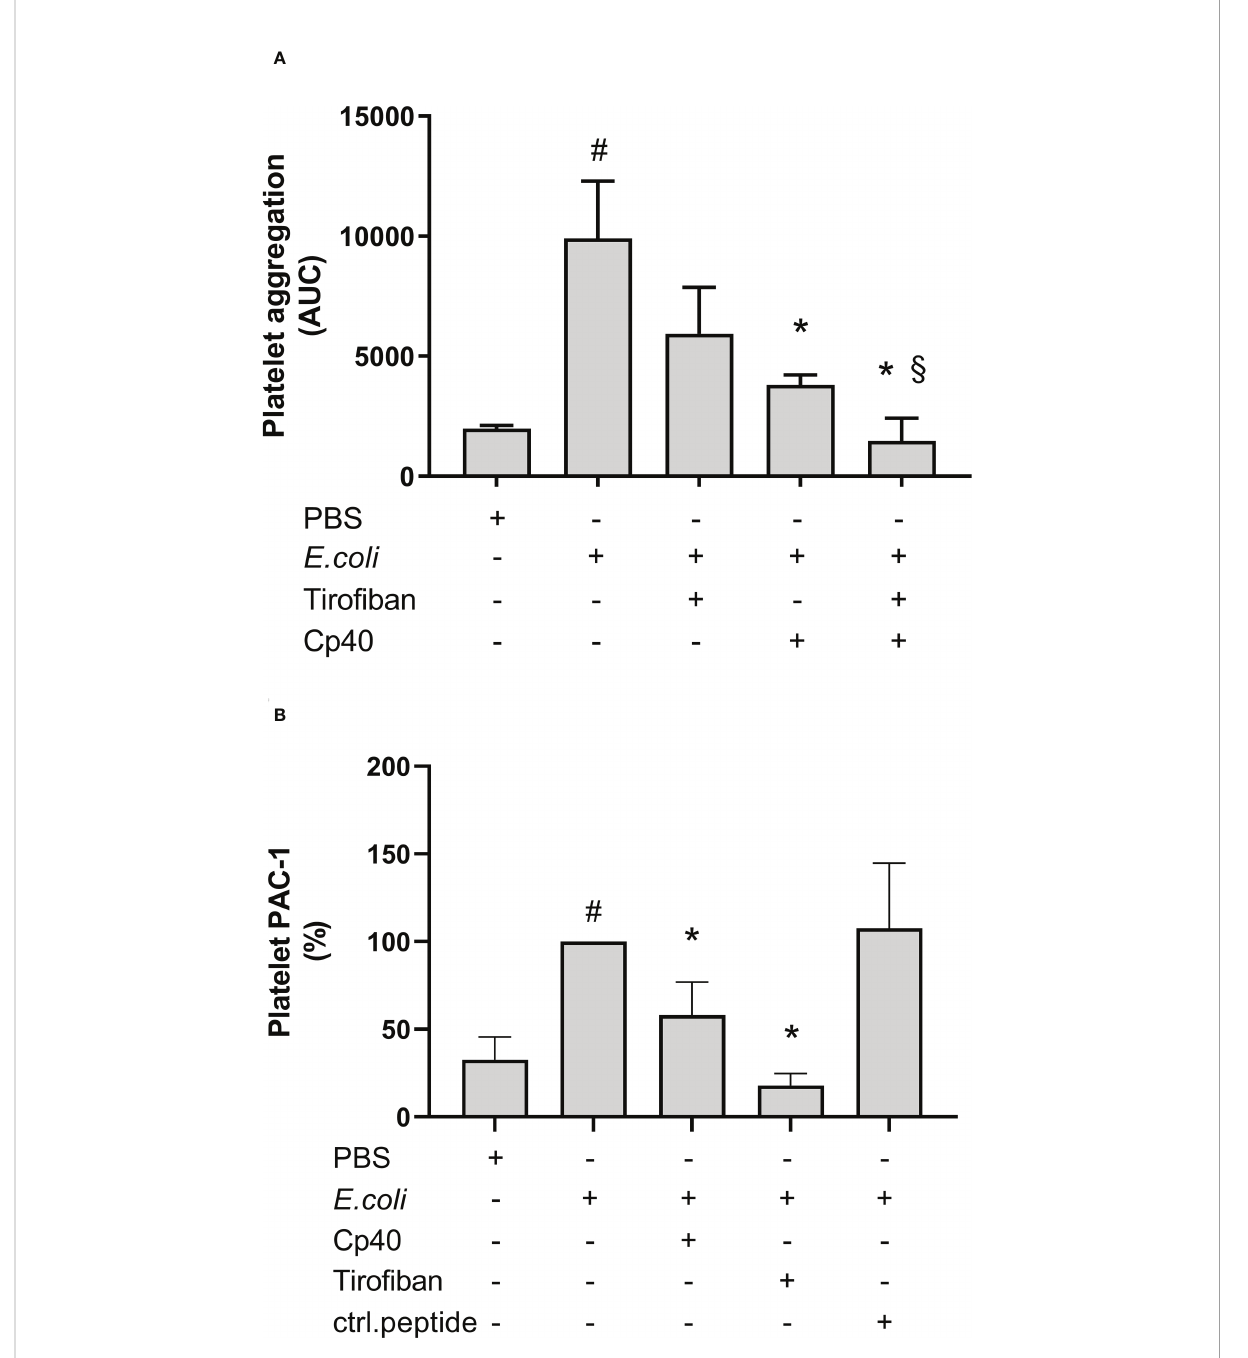
FIGURE 7 The role of glycoprotein (GP) IIb/IIIa on Escherichia coli ( E. coli 5.3 x 10 9 /mL)-induced platelet aggregation measured by Multiplate ® impedance aggregometry (A) . To the samples were added phosphate-buffered saline (PBS) control, tiro fi ban (5 µg/mL), compstatin (Cp40, 20 µM) or the combination of tiro fi ban and compstatin, and PBS or E. coli as activators. The results are given as the area under the curve (AUC), using median ± interquartile range (n = 6). The effect of C3-inhibition on the E. coli -induced (1 x 10 9 /mL) activated GPIIb/IIIa on platelets measured by fl ow cytometry (B) . To the samples were added PBS control, tiro fi ban (5 µg/mL), compstatin (Cp40, 20 µM), or control peptide (ctrl.peptide, 20 µM), and PBS or E. coli as activators. A BV605-labeled anti-human CD61 antibody was used to gate the platelets and a FITC-labeled anti-human PAC-1 antibody was used to detect the activated GPIIb/IIIa receptors. Results are expressed as percent of the uninhibited sample ( E. coli without inhibition set to 100%) and are given as median ± interquartile range (n = 16). #; p < 0.05 analyzed using a Wilcoxon test between the samples with and without E. coli , *; p < 0.05 analyzed using a Friedman test and Dunn ’ s multiple comparisons test, comparing E. coli -activated samples without and with inhibition or control. §; p < 0.05 analyzed using a Wilcoxon test between the E. coli -activated samples with compstatin (Cp40) and with the combination of compstatin and tiro fi